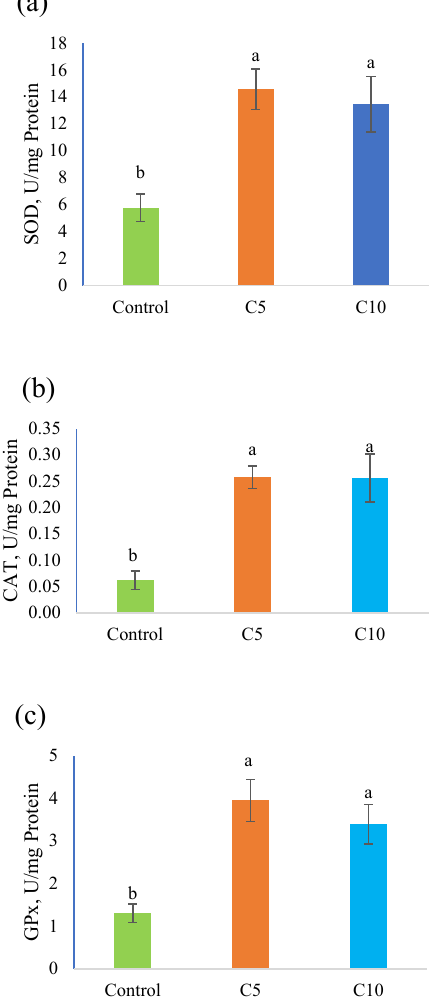
Figure 4. Antioxidant’s potential in red tilapia fry (30 dph). ( a ) Superoxide dismutase (SOD); ( b ) catalase (CAT); ( c ) glutathione peroxidase (GPx). Means with different letters are different.